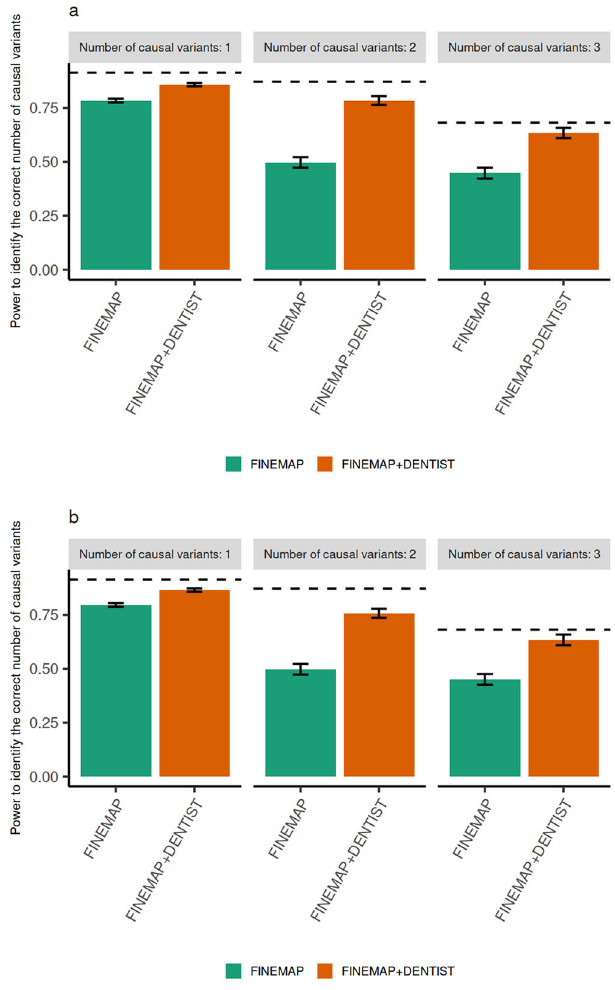
Fig. 3 Power of FINEMAP with and without DENTIST QC. The power of FINEMAP is measured by the percentage of simulation replicates in which the number of causal variants is correctly identi fi ed under the simulation scenario with 1, 2, or 3 causal variants. In a , LD reference = HRS. In b , LD reference = ARIC. The horizontal dashed line in each bar plot shows the benchmark, i.e., the power of FINEMAP when using in-sample LD. The height of each bar plot represents the power estimated from the pooled results of 2200 replicates. The error bar represents s.e. estimated from binomial distribution. Source data are provided as a Source Data fi